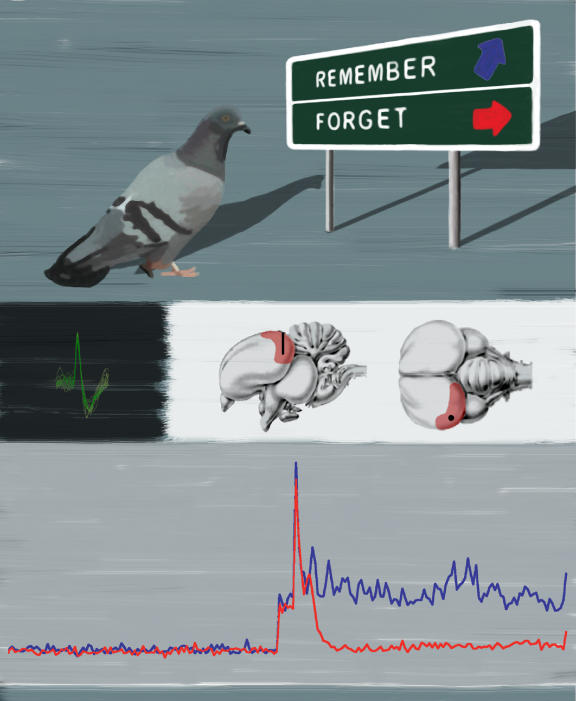
Neurons in the avian version of the prefrontal cortex fire when pigeons perform memory tasks and may play a role in higher cognitive processes such as decision making and reasoning